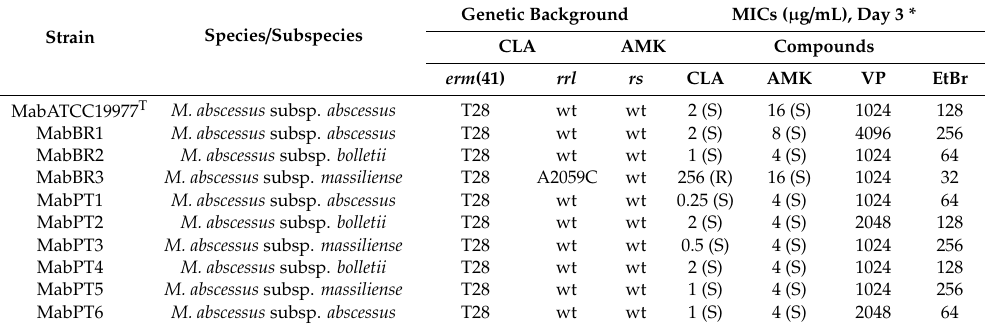
Table 1. Phenotypic and genotypic characterization of the M. abscessus strains studied. Strain Species / Subspecies